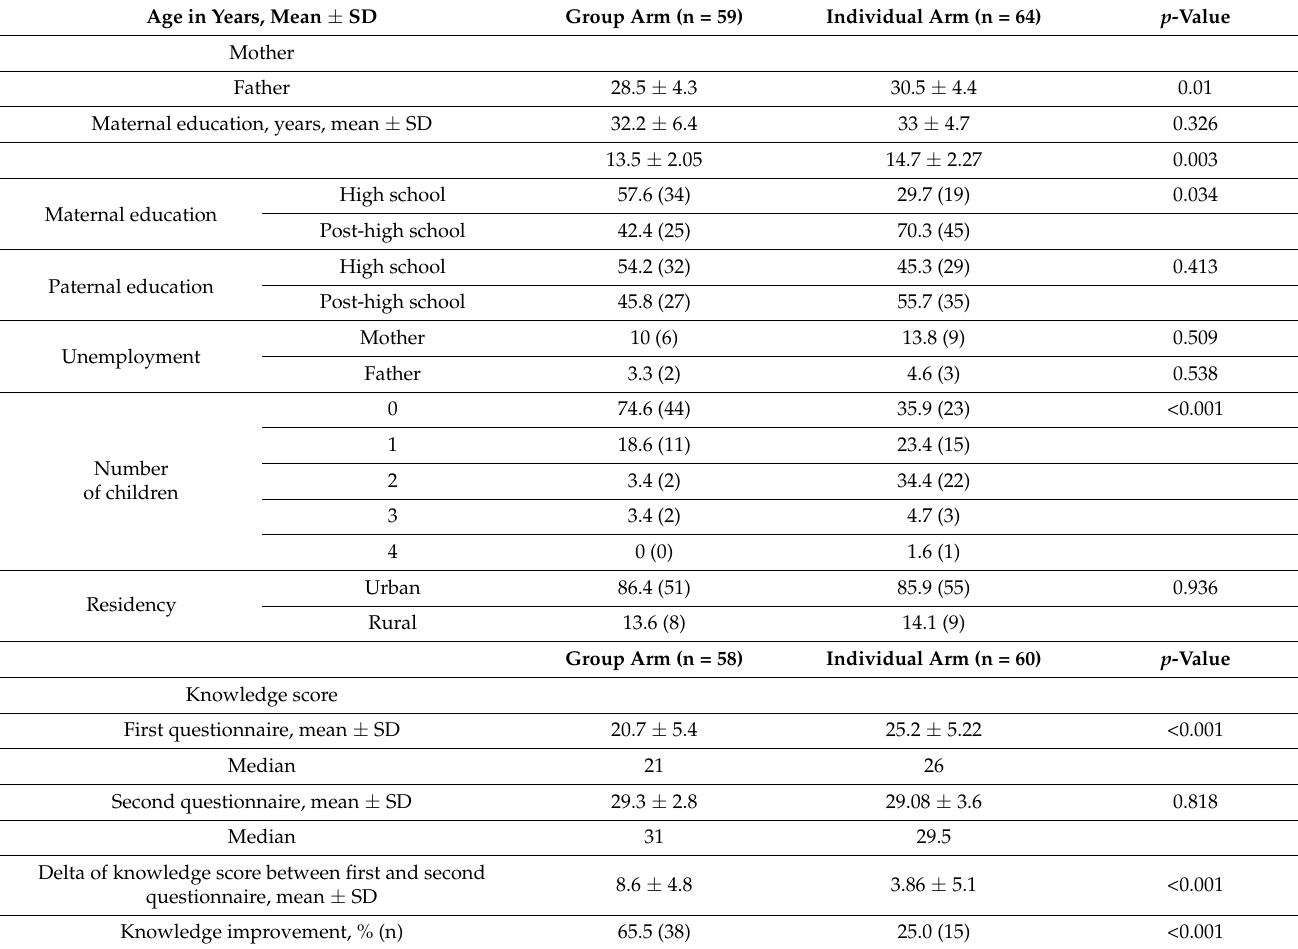
Table 1. Socio-demographic characteristics and knowledge score and improvement comparison by study